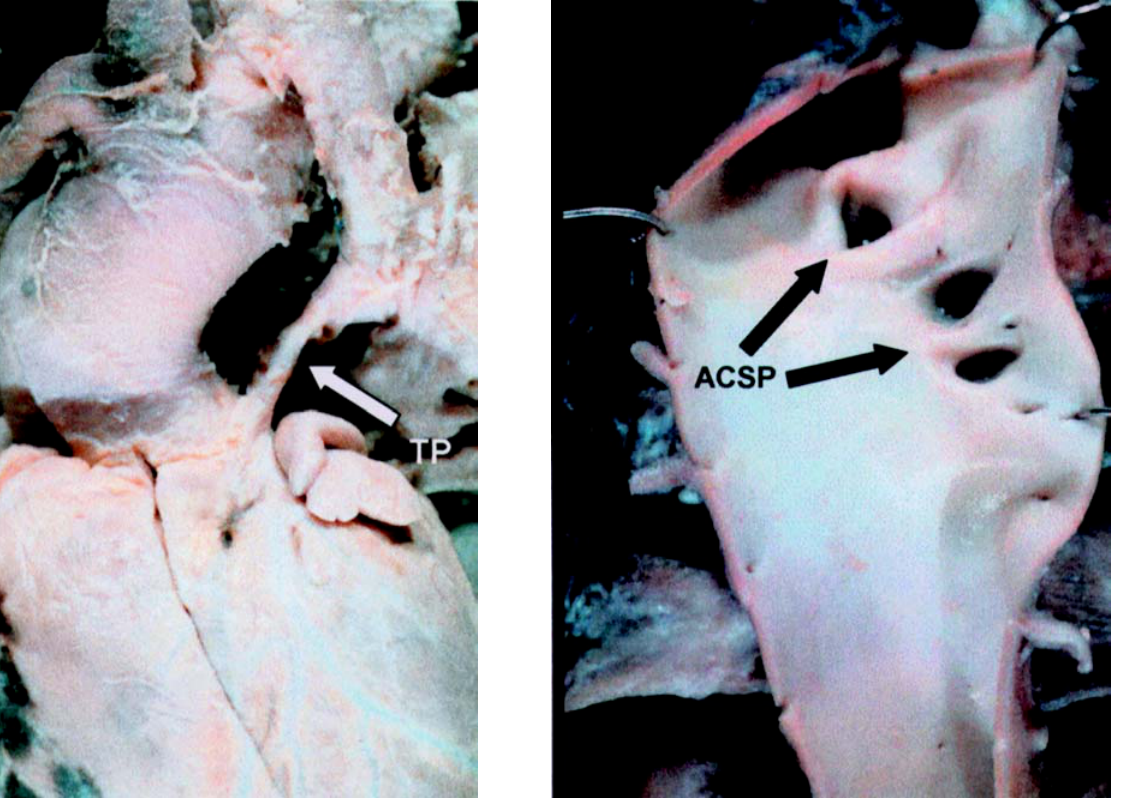
(ACSP).Fig.1– Espécime anatômico típico de atrelmonar. TP= tronco